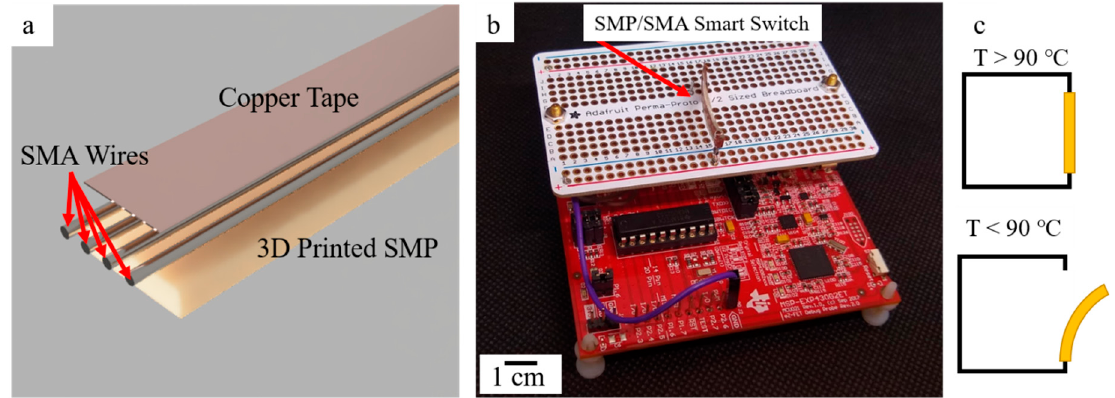
Figure 3. ( a ) Digital render (Fusion 360) showcasing the design of the SMP/shape memory alloy (SMA) smart switch. ( b ) The fabricated SMP/SMA switch connected to a breadboard and the MSP430. ( c ) A diagram illustrating the switch in the “on” position ( top ), and “off” position ( bottom ) .